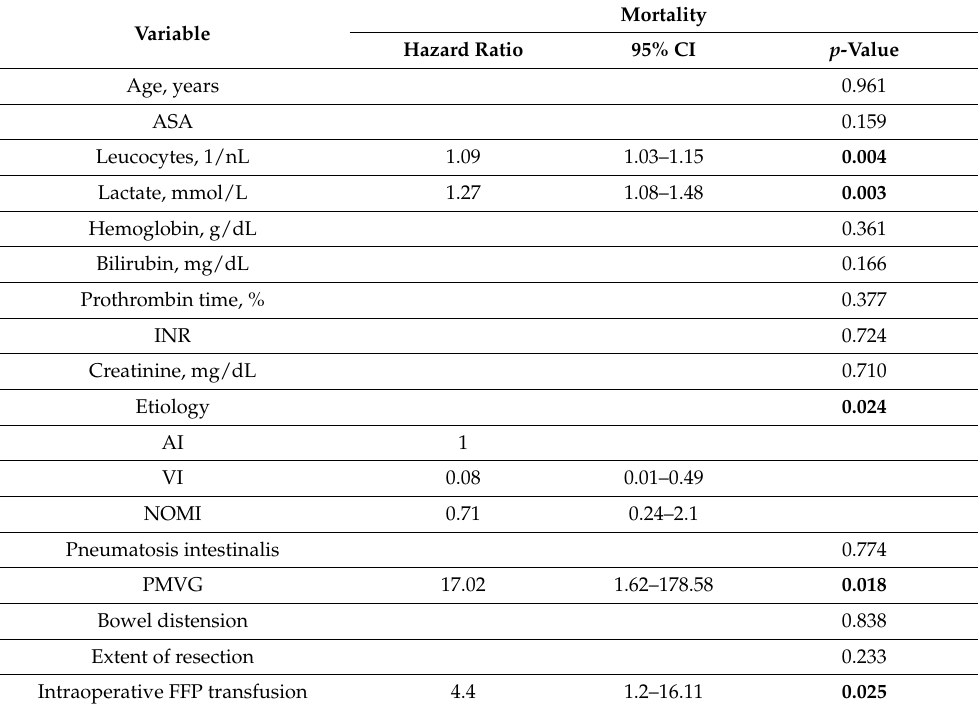
Table 3. Multivariable analysis of in-hospital mortality (fatal situation in primary operation